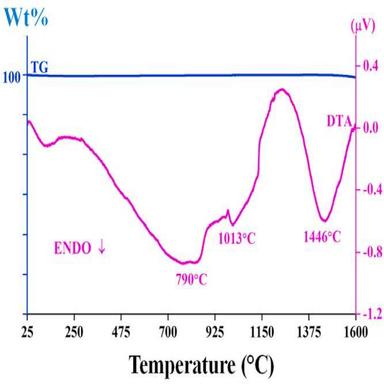
TG/DTA curves and Curie temperature of Yb1.90Eu0.10Sn2O7.